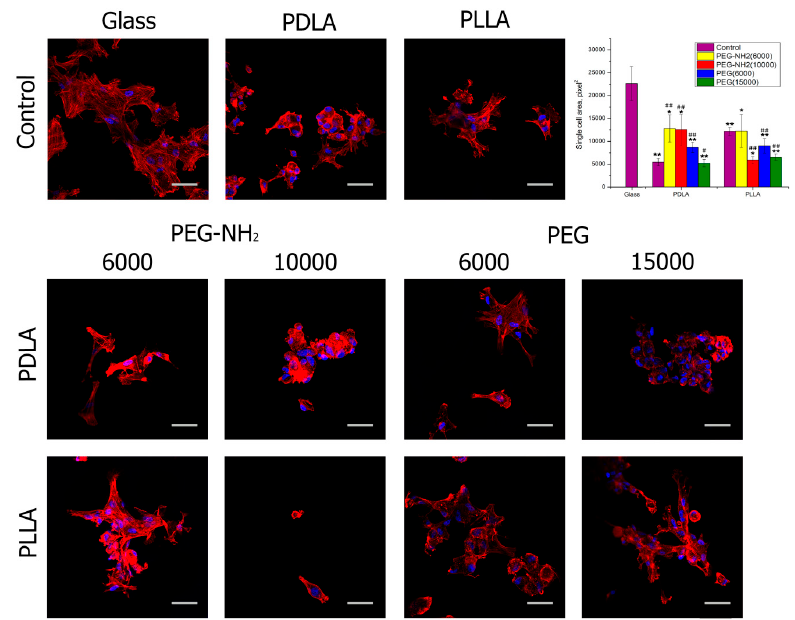
Figure 4. Fluorescence microscopy of the fetal mesenchymal stromal cells (FetMSC)s after 2 h of cultivation on the pure glass and on the pure films from PLA with different isomeric forms—PDLA and PLLA (control); the blend PLA/PEG or PLA/PEG-NH2 with different molecular weights of PEG (6000 or 15,000 g/mol) and PEG-NH2 (6000 or 10,000 g/mol). N = 5: ⭑ — p < 0.01, ⭑⭑ — p < 0.05 for the same concentration data, #— p < 0.01, ##— p < 0.05 compared with the unmodified PCL. Staining—rhodamine-phalloidin (red), 4 ′ ,6-diamidino-2-phenylindole (DAPI) (blue). Scale bar 50 µm. Polymers 2020 , 12 , x FOR PEER REVIEW